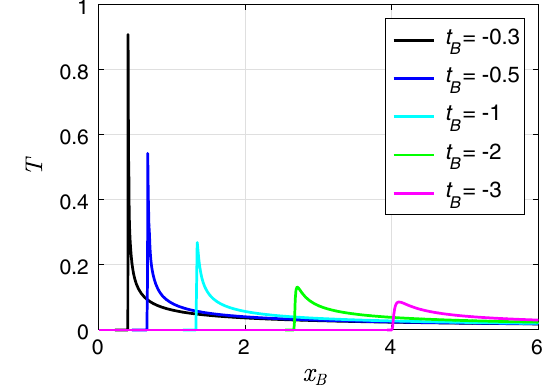
FIG. 7. Boosted Green ’ s function of the heat equation for t < 0 . We set D ¼ 30 and v ¼ 3 = 4 . Each curve represents a B ; x snapshot of T ð t , for different choices of t . If someone B B Þ B knows the entire history of the system, the interpretation of this figure is quite straightforward: Alice injects a spike of energy at 0 ; because of acausality, a portion of such a spike t x B ¼ B ¼ propagates toward the past; as it travels backward in time, the spike diffuses and flattens. On the other hand, to Bob (who cannot predict the decisions of Alice), the situation looks very different. From his perspective, the material is initially in thermodynamic −∞ ). Then, a perturbation builds up equilibrium (at t B ¼ spontaneously, developing a superluminal front on the character- − t =v . As time goes ahead, the perturbation istic line x B ¼ B “ antidiffuses, ” becoming more and more peaked. Eventually, → 0 , the peak diverges at x 0 . What we are when t B B ¼ observing is just an inversion of chronology (see Fig.